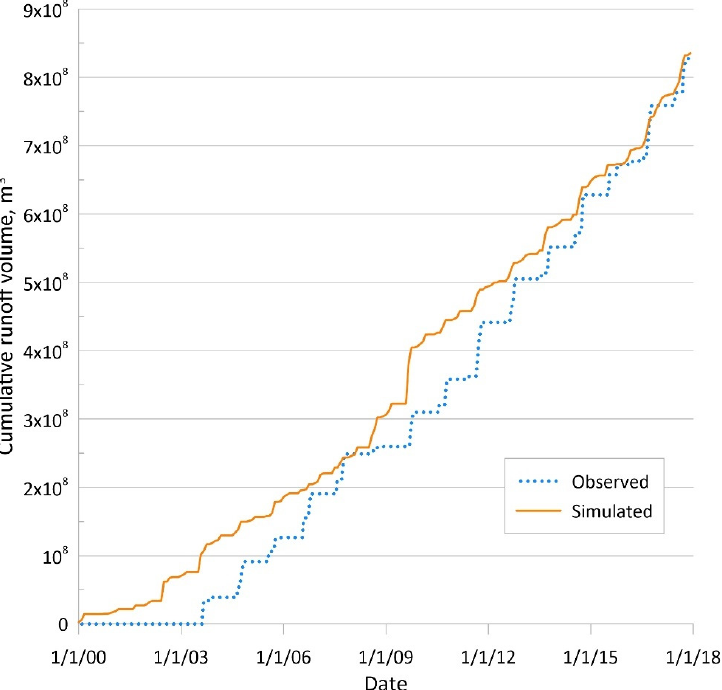
Figure 12. Simulated and observed cumulative runoff volumes at the Dongjuyanhai gauging station for the period 2000–2017.